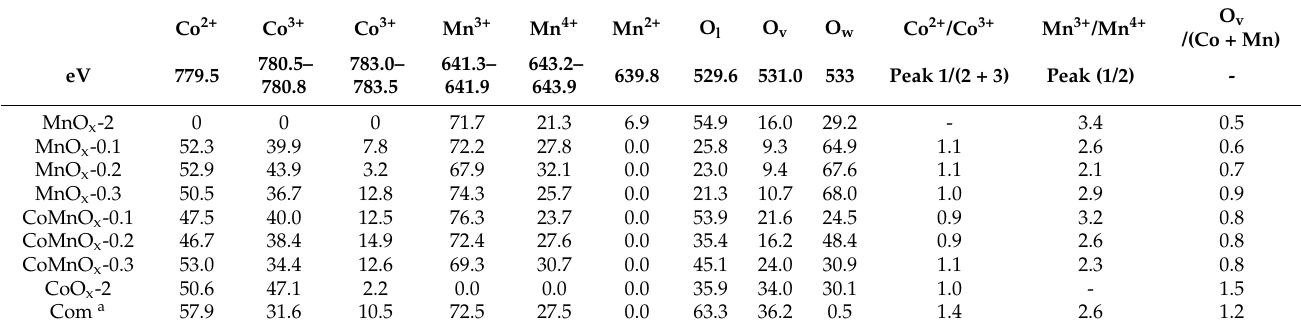
Table 5. Normalized concentrations of deconvoluted Co 2p, Mn 2p and O 1s peaks (in rel. %) and molar ratios of Co 3+ /Co 2+ , Mn 3+ /Mn 4+ , and oxygen vacancies O v /(Co + Mn) ions. Co